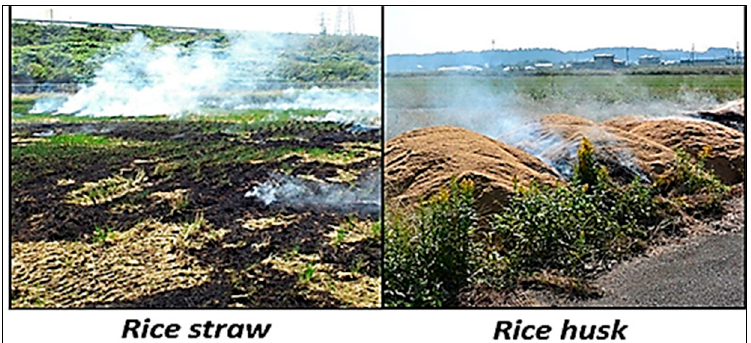
Figure 6. Rice waste disposal and its environmental impacts.